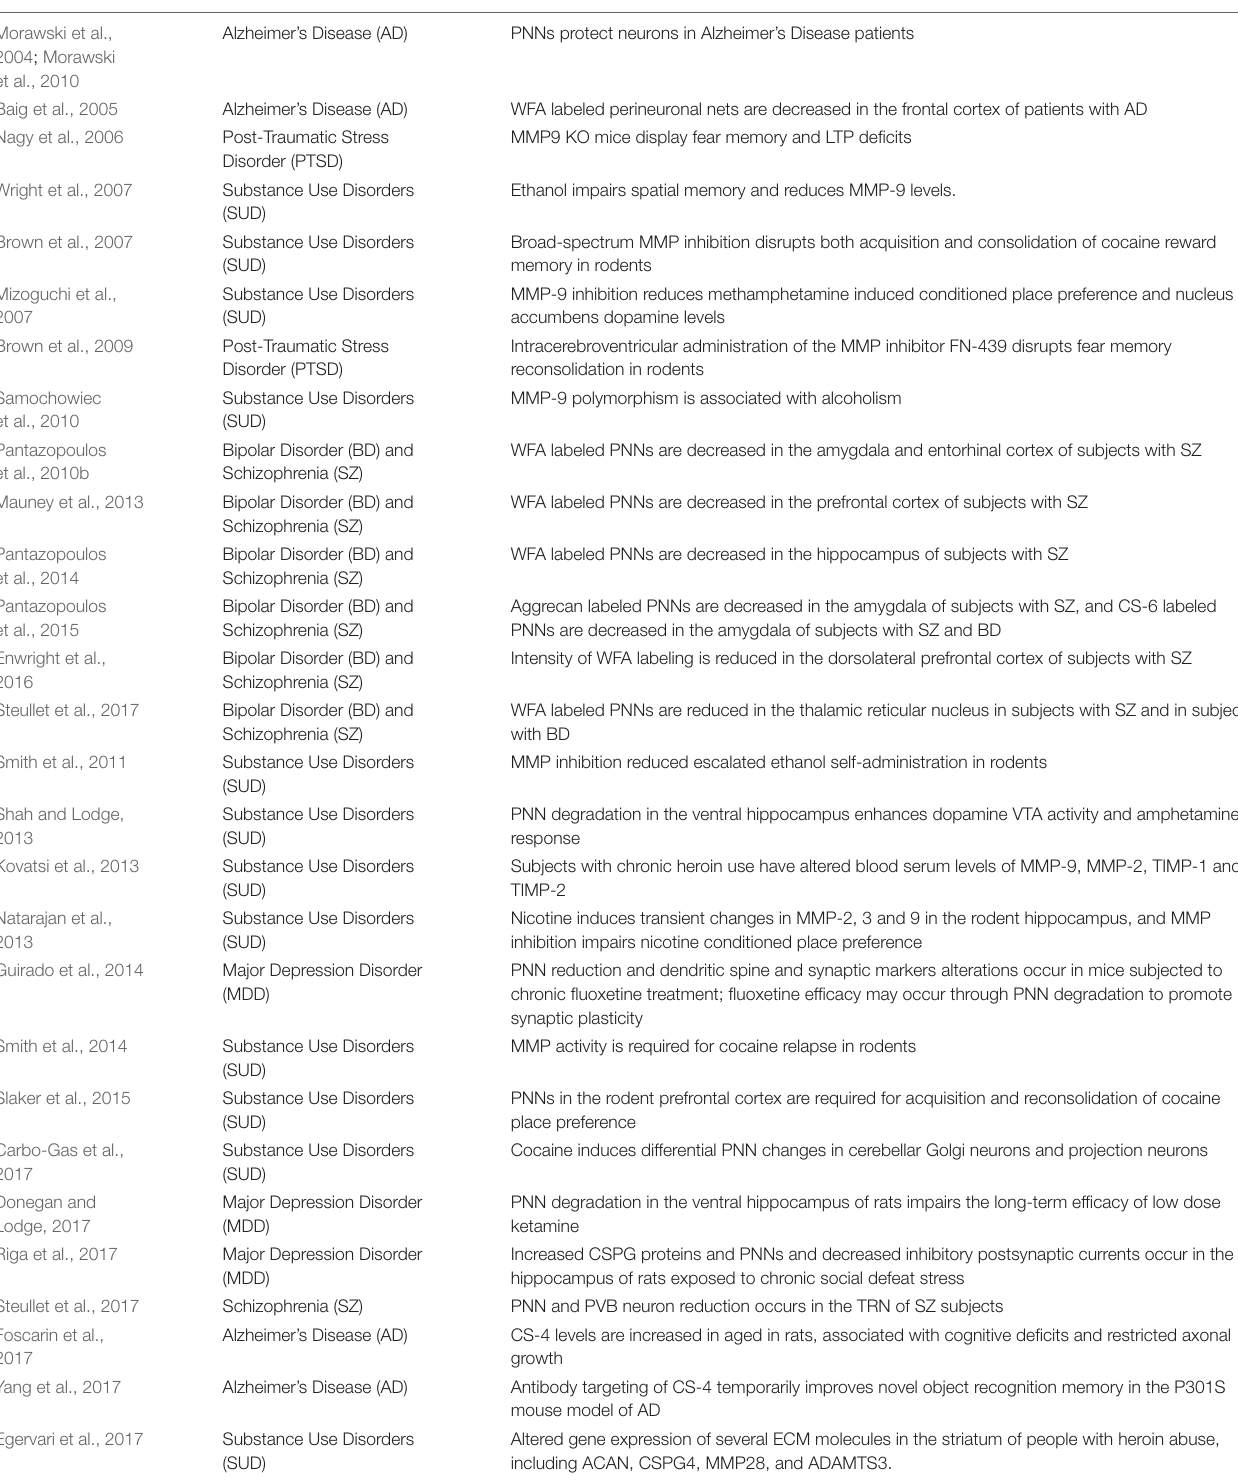
TABLE 2 | Evidence for ECM molecules and PNNs in psychiatric